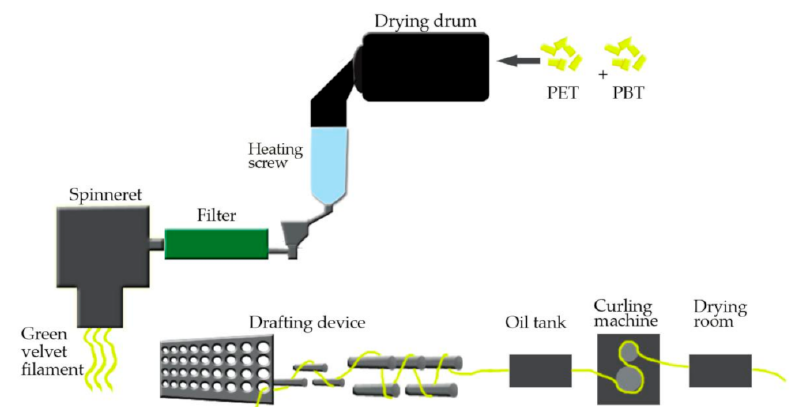
Figure 1. Schematic diagram of PLON fiber production.